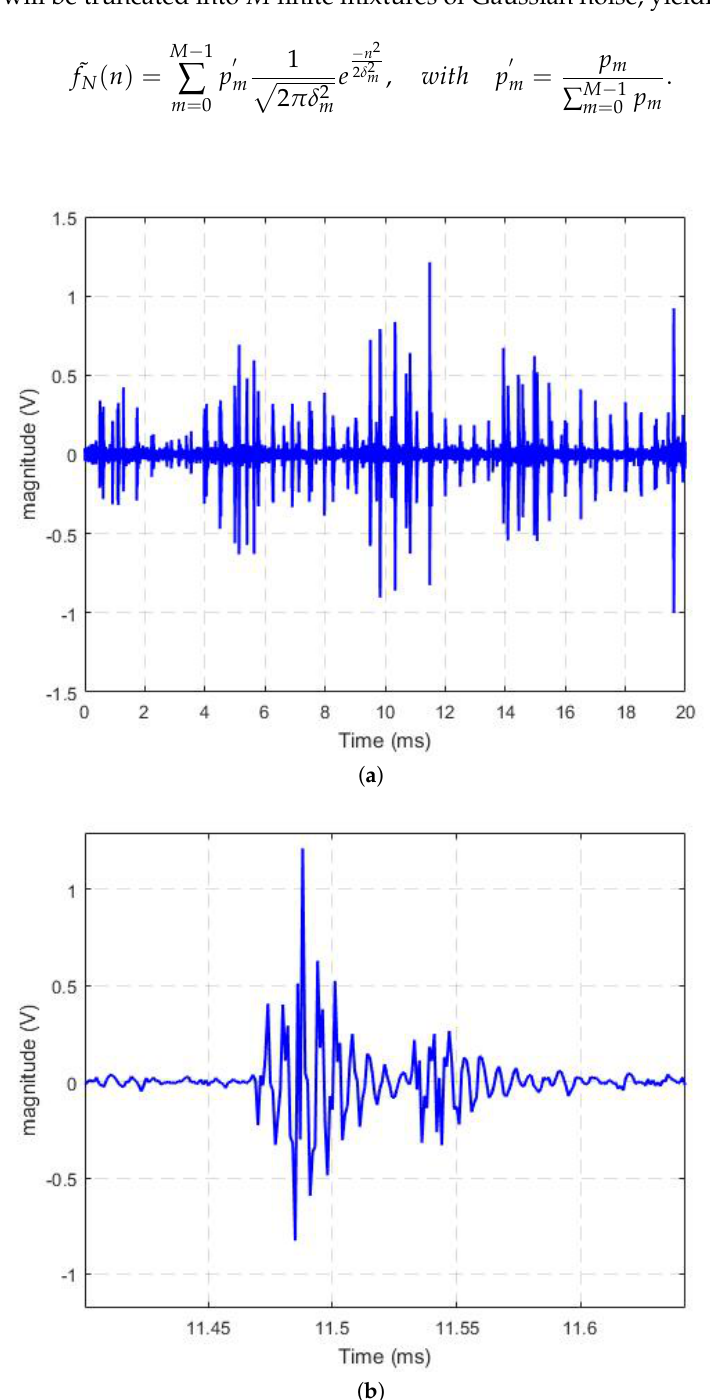
Figure 7. Noise measured in China without NBI ( a ) 20 ms time windwow; ( b ) short time